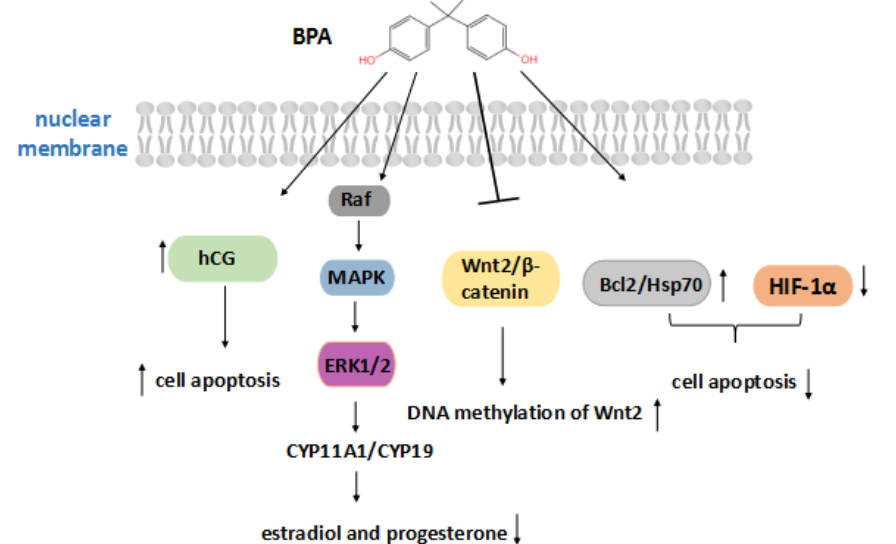
Figure 2. BPA action on placental growth. The arrow facing up indicates an increase, and the arrow facing down indicates a decrease, due to BPA. Bisphenol A increases the secretion of hCG and cell apoptosis, or activates the ERK signaling pathway to reduce estradiol and progesterone hormones, and also inhibits the expression of Wnt2 / β -catenin. On the other hand, BPA can increase the levels of Bcl-2 and Hsp70 and reduce the level of HIF-1 α to reduce apoptosis.